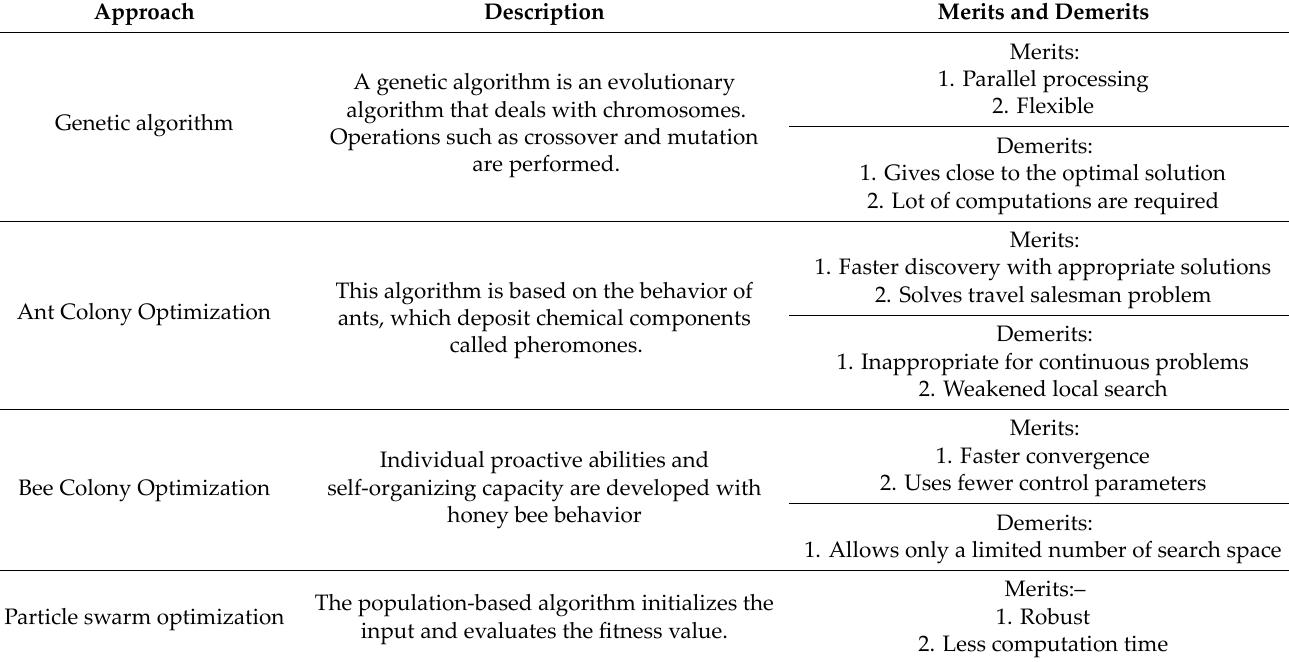
Table 8. Comparison of optimization approaches.